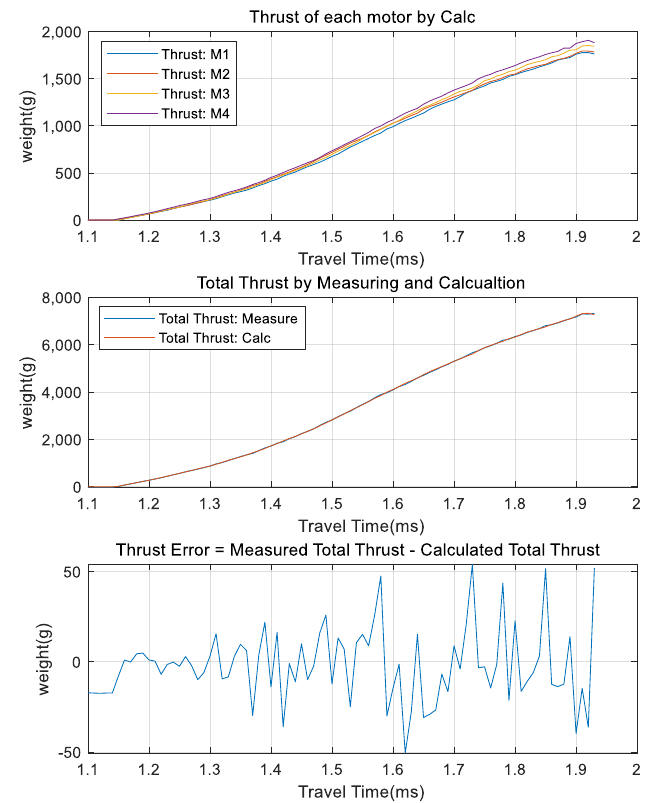
Figure 17. Comparison of thrust by measurement and thrust by calculation.